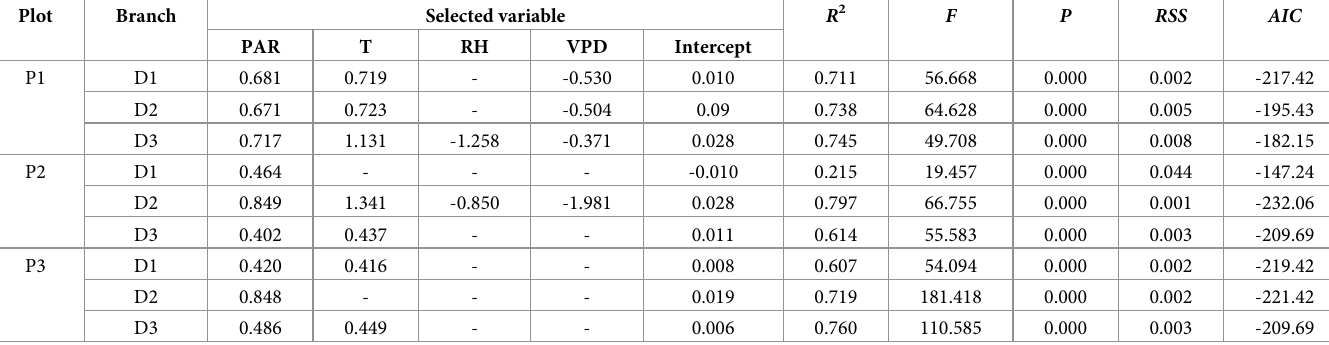
Note: R 2 indicates Determination coefficient or goodness of fit, it is used to measure the degree to which the estimated model fits the observed value; F value is the result of Analysis of variance, which is an overall test of the whole regression equation. It means whether the whole regression equation has any use value. If the P value corresponding to F value is less than 0.05, the regression equation can be considered